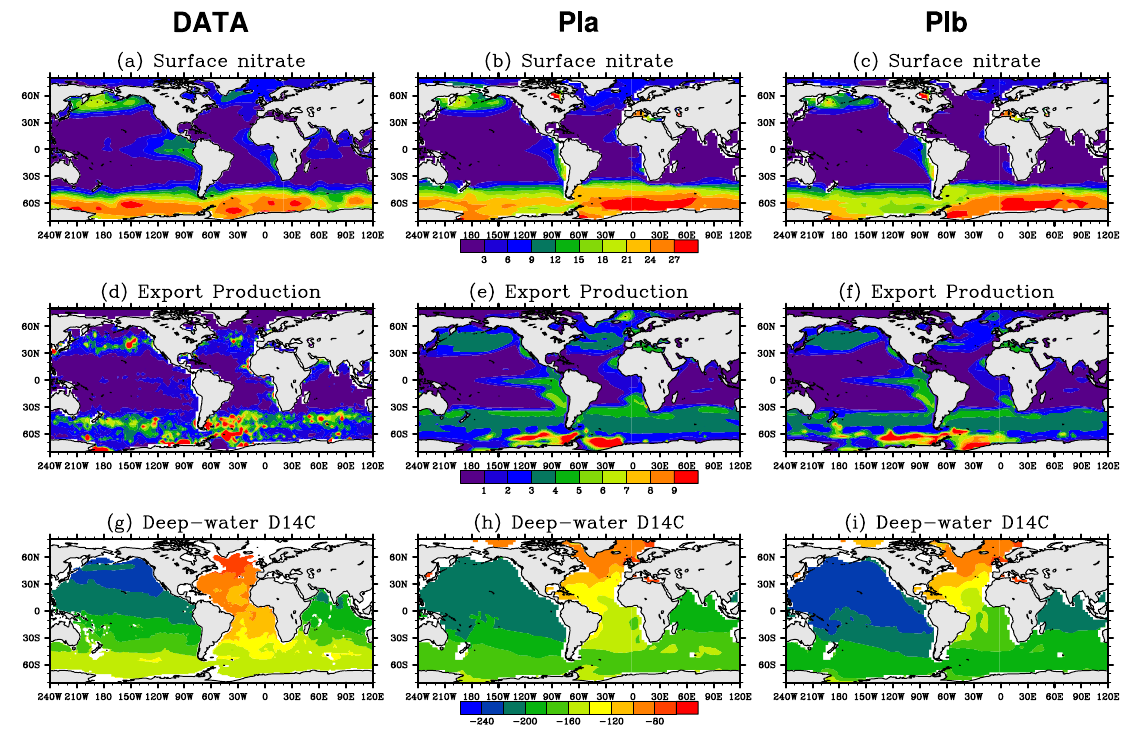
Fig. 1. Annual mean of nitrate concentration within the euphotic zone (mmolm − 3 ), export flux of POC (molCm − 2 yr − 1 ) and radiocarbon below 1500m (‰) for observational data (left panels), PIa (center), and PIb (right). Observational data refer to nitrate from Levitus World ocean atlas (Levitus et al., 1994). Export flux is estimated by Oka et al. (2008) based on the primary production algorithms (Behrenfeld and Falkowski, 1997) and the particle export ratios (Dunne et al., 2005). Natural radiocarbon data are taken from Global Ocean Data Analysis Project (Key et al.,